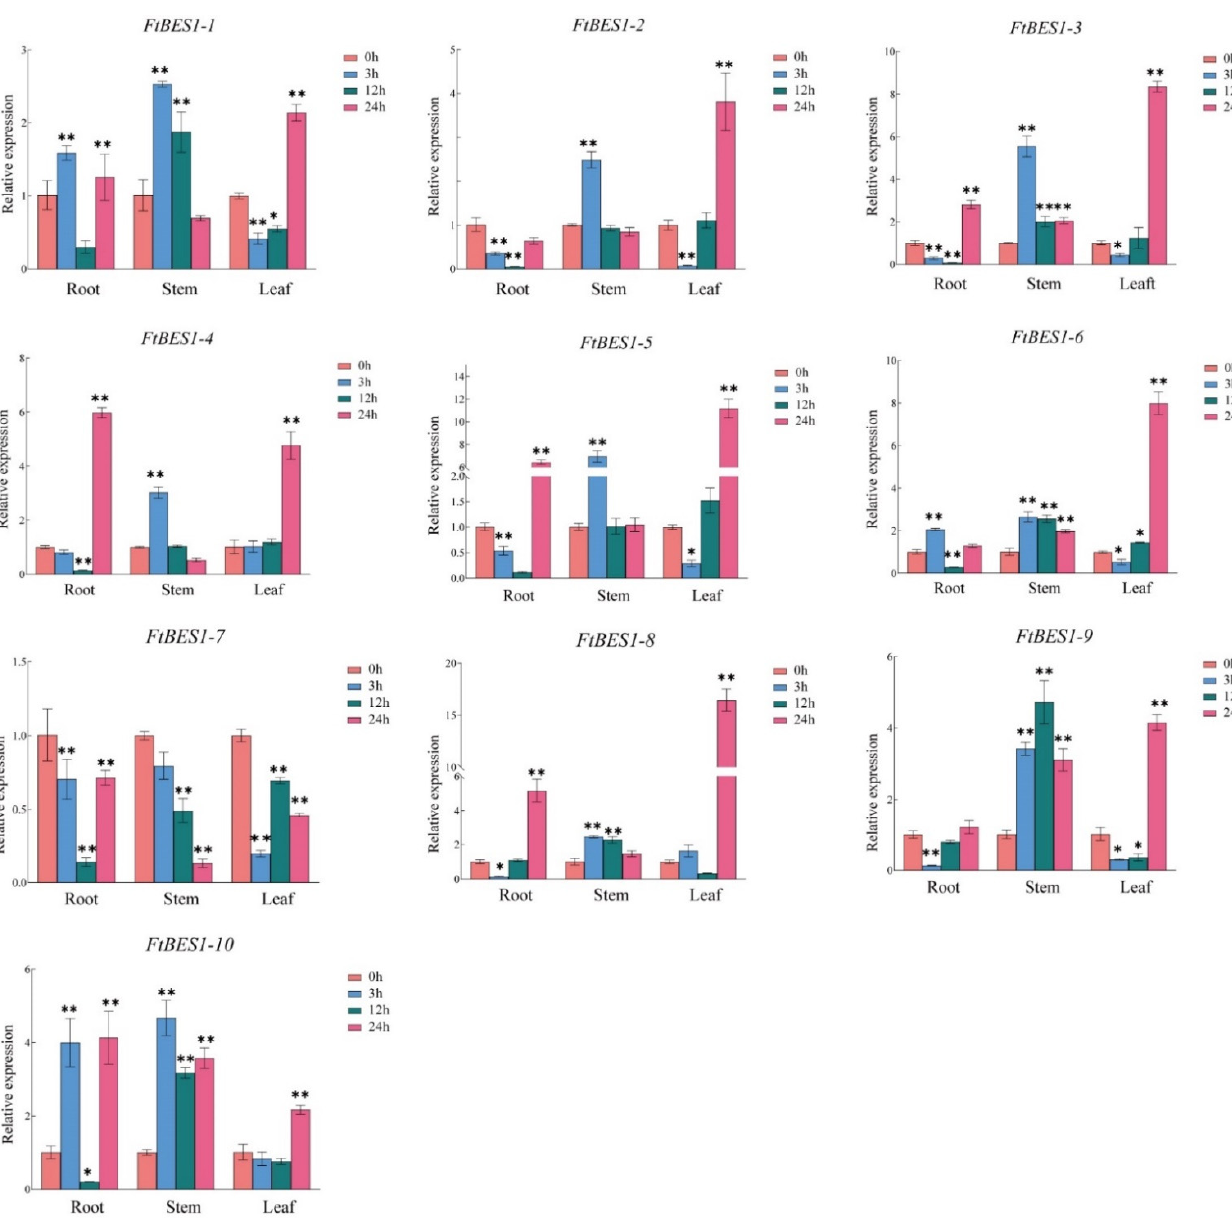
ered for each experiment. Error lines indicate standard errors of three independent biological rep-